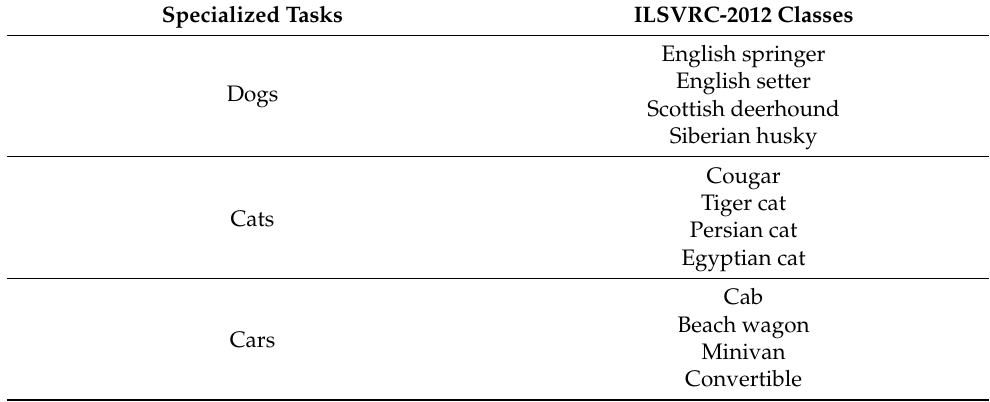
Table 1. Specialized task